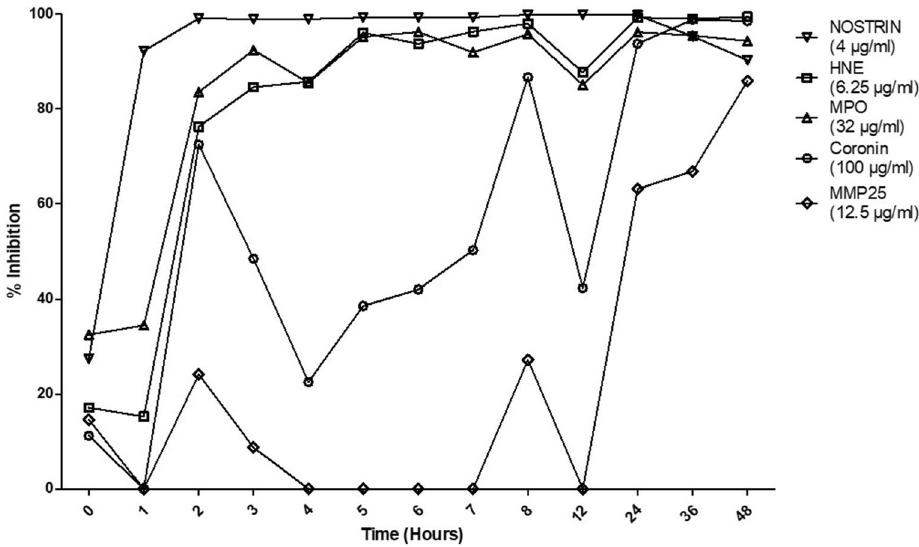
Figure 3. Time-kill Plots Demonstrating Cryptococcal Inhibition by Lysosomal Proteins. C. neoformans strain H99 yeast cells were grown in YPD broth for 18 h in a 30 °C shaking incubator, then washed and adjusted to a concentration of 1 × 10 5 cells/ml. Fungi were incubated in phosphate buffer alone (pH 5.5) or in phosphate buffer with each protein at 2X MIC for 48 h at 35 °C. Aliquots were taken and plated for CFUs for each hour 0–8, and at 12, 24, 36, and 48 h. Percent inhibition is defined as 100%—(protein CFUs/control CFUs) × 100%. Data shown are means of two independent experiments (n = 2). Lysosomal proteins NOSTRIN, HNE, and MPO showed sustained cryptococcal inhibition by 3 h post-inoculation while coronin displayed intermediate inhibition and MMP25 exhibited no cryptococcal inhibition at the same time point. From 24–48 h all proteins inhibited cryptococcal growth.